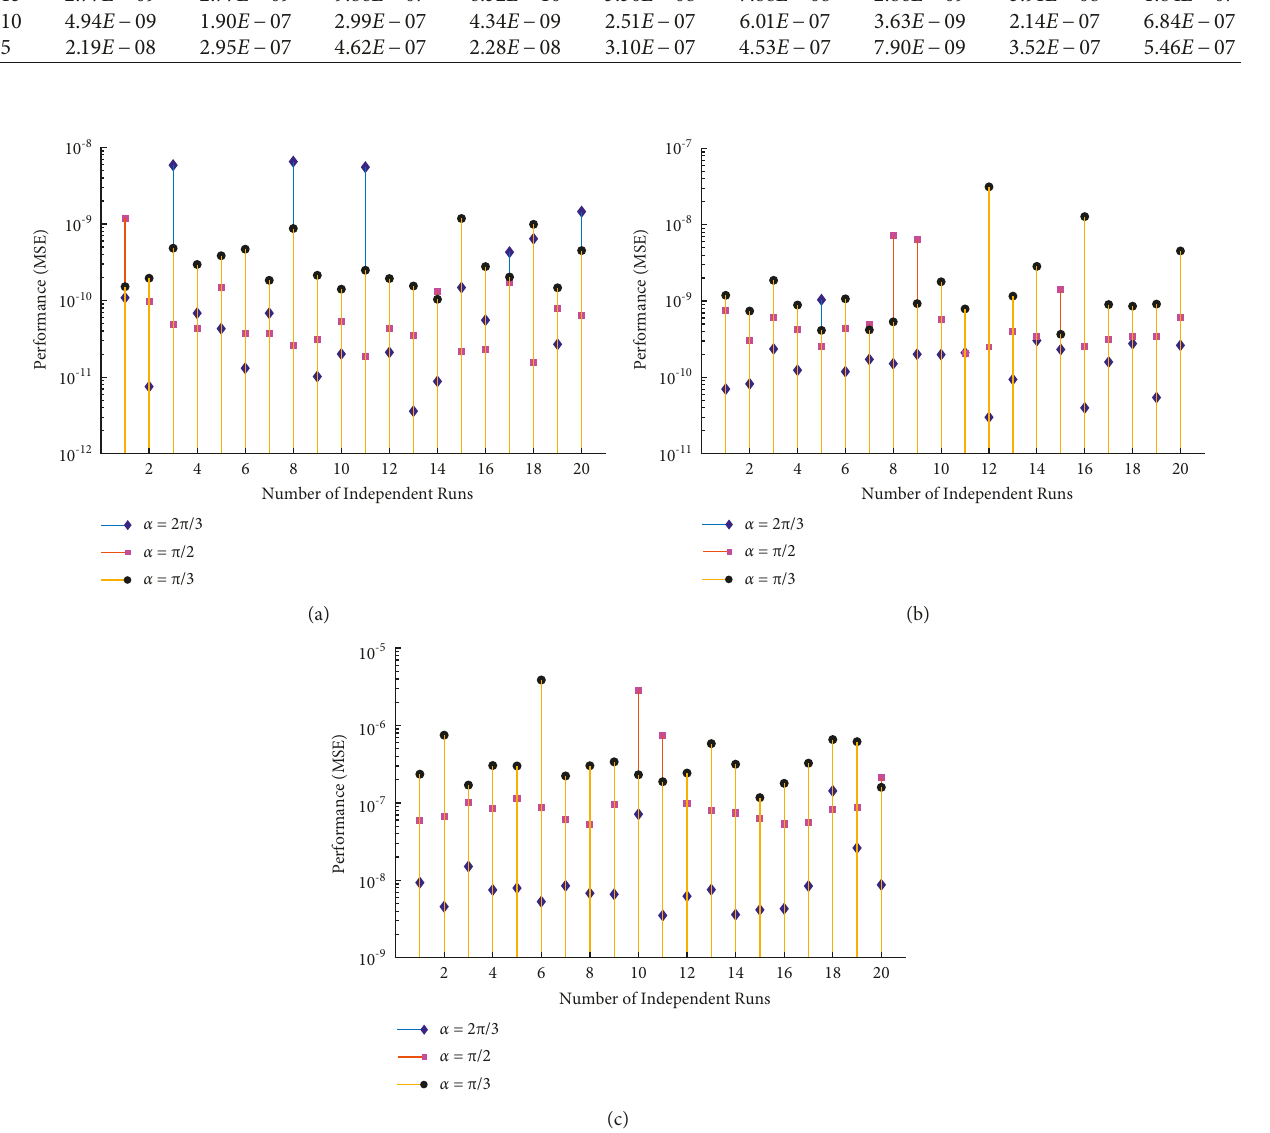
Table 6: Results of the gradient in terms of minimum, the mean, and standard deviation for different cases and scenarios of the problem. Case I Case II R